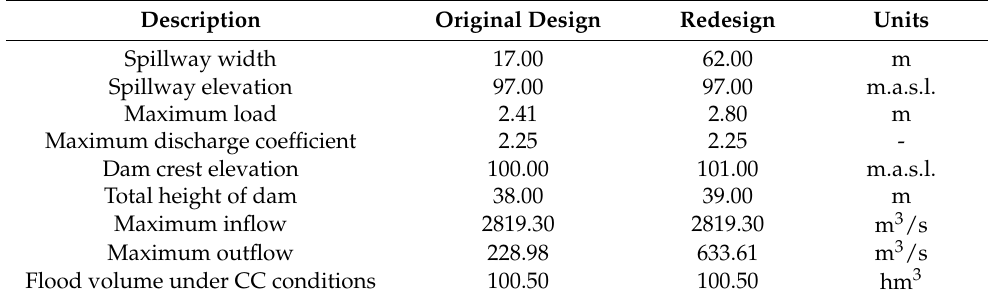
Table 4. Comparison of the hydraulic parameters between the original design and the redesign for the Sube y Baja dam.